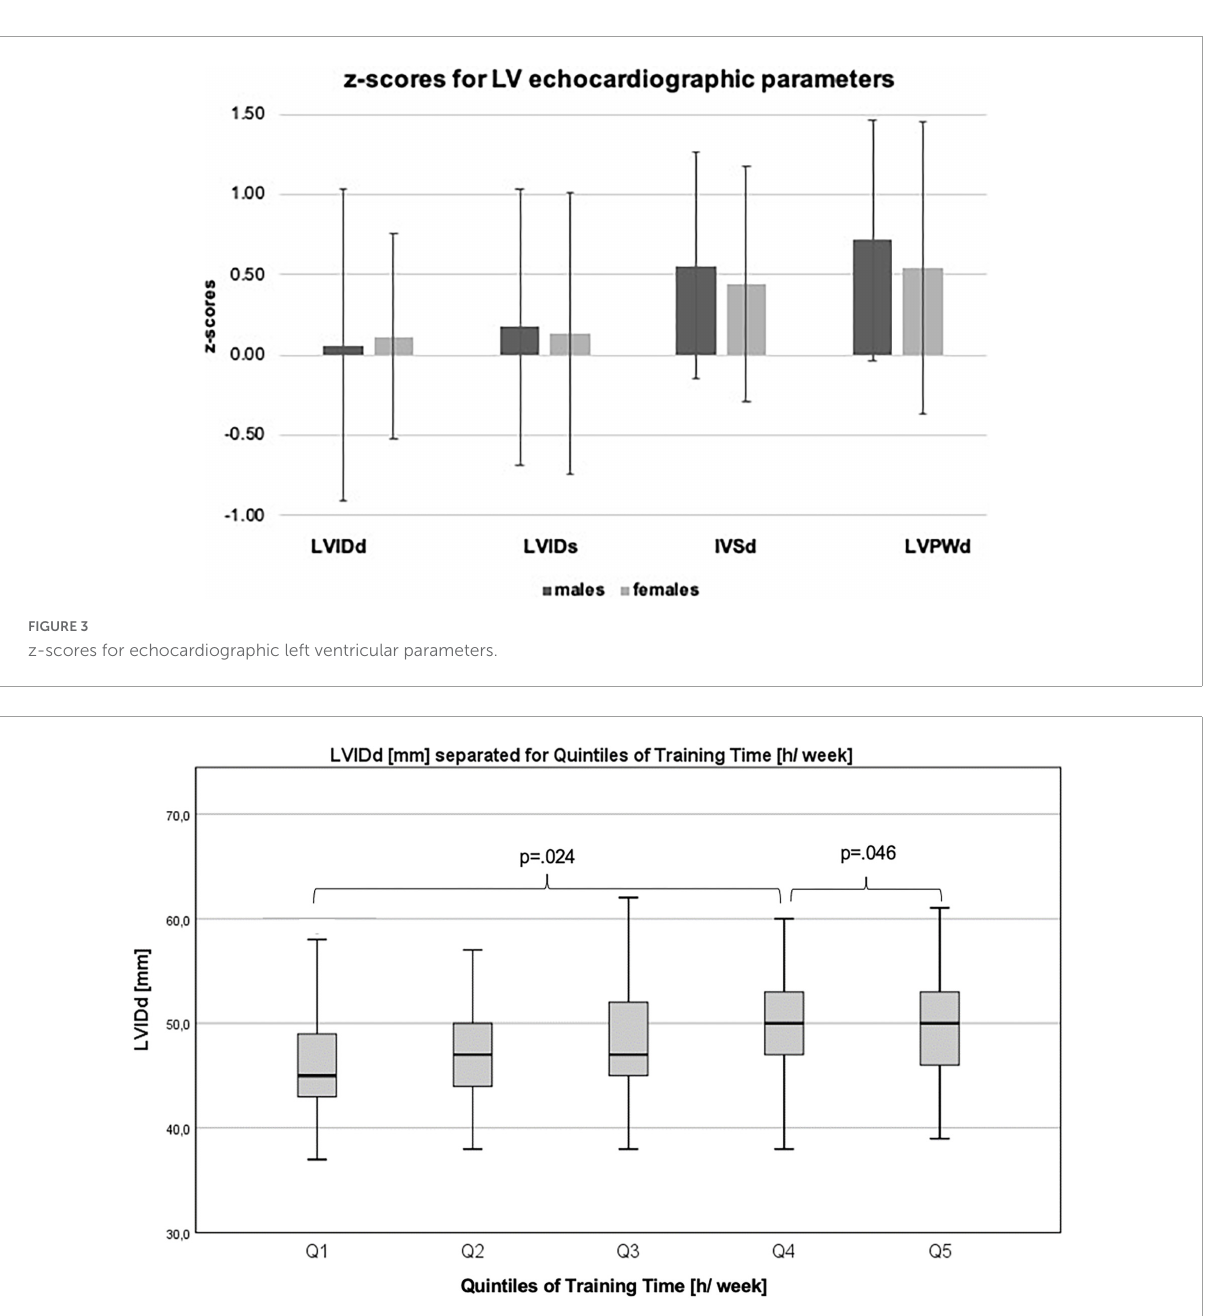
FIGURE4 Differences in left ventricular internal diameter in diastole between quintiles of training